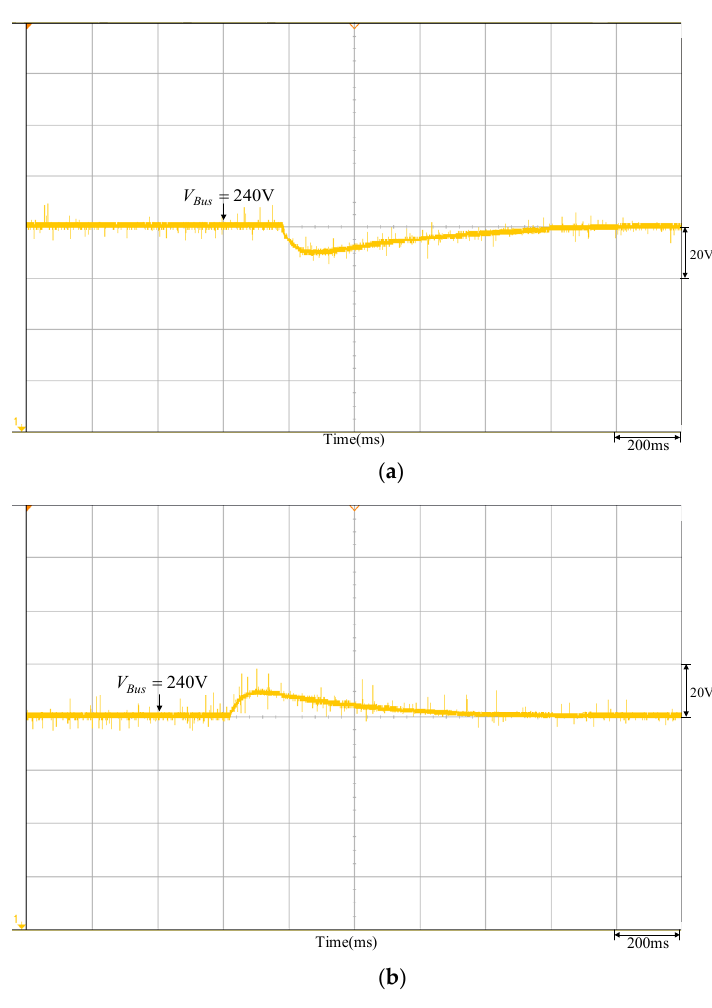
Figure 15. DC-link voltage response waveform of the traditional P-I controller obtained by the trial- and-error method: ( a ) sunlight drops to 900 W/m 2 from 1000 W/m 2 ; ( b ) sunlight increases to 1000 W/m 2 from 900 W/m 2 .